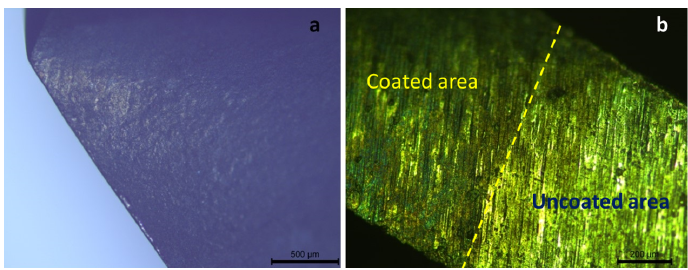
Figure 7. Optical microscopy images corresponding to carbon thin film deposition on metal piercing drills: ( a ) drill tip and ( b ) interface between coated and uncoated areas.